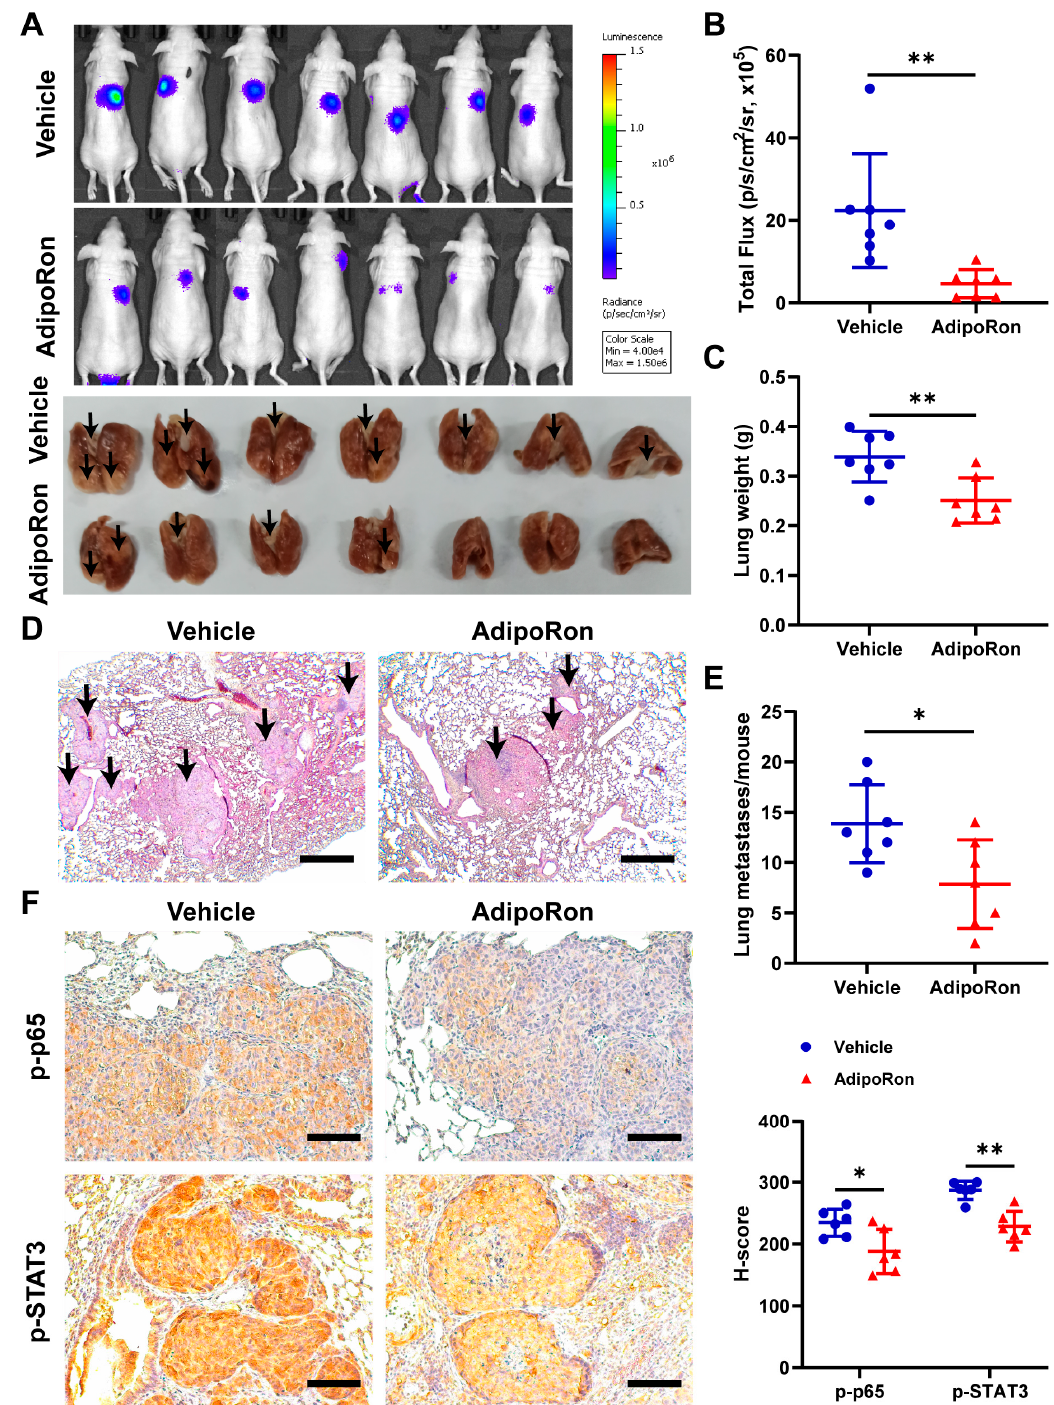
Figure 7. AdipoRon inhibits NPC tumor metastasis in vivo. ( A ) Bioluminescent (upper) and lung (lower) images from 5-8F-luc cells’ lung metastasis model after oral administration of AdipoRon (50 mg/kg/d) or vehicle ( n = 7 per group). The black arrows indicate metastatic tumors. ( B ) Quantifica- tion of in vivo bioluminescent images (photon/s of lung region). ( C ) Wet lungs were counted and summarized. ( D ) Representative H and E staining of lung section. The black arrows indicate meta- static tumors. ( E ) The number of lung metastases were counted and summarized. Scale bar: 200 μ m. ( F ) Immunohistochemistry of p-p65 and p-STAT3 protein levels in metastatic 5-8F-luc cells from the lung ( n = 6). Scale bar: 100 μ m. Quantification of protein expression in metastatic 5-8F-luccells. Re- sults are presented as mean ± SD of three independent experiments performed in triplicate. * p < 0.05, ** p < 0.01.